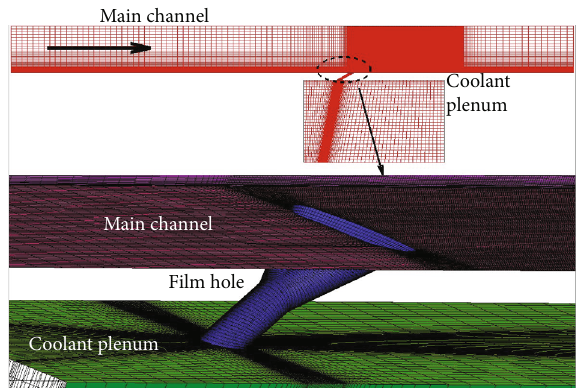
Figure 8: Computational model and mesh distribution around a typical fi lm hole.